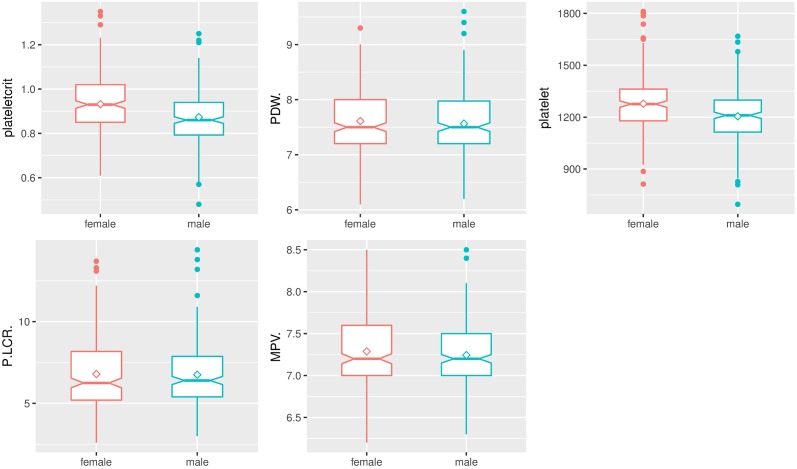
Box and whisker plots show differences in analyte levels of male and female Sprague-Dawley rats on platelet parameters.Data were depicted as box plots that indicated the median, 25th and 75th percentiles (box), mean (◇), and 1.5 times of interquartile (whiskers). Male rats were indicated by a green line, and female rats were indicated by a red line.